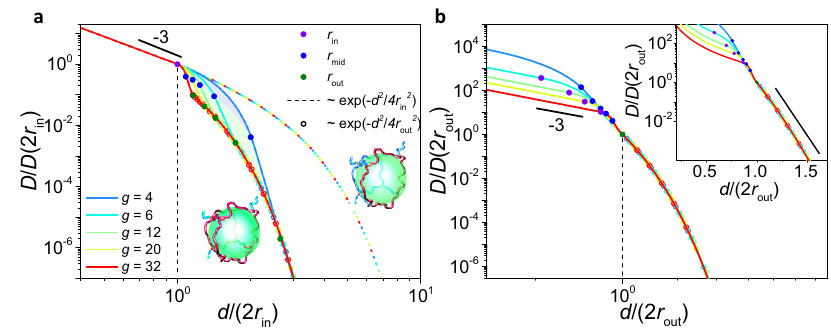
Fig. 4 Dynamical regimes mediated by network topologies. a D / D (2 r in ) against d /2 r in for various network cell topologies in the log-log scale. Inset: schematic diagrams of the deformation based on a network cell (left) and the deformation based on a network loop (right). b D / D (2 r out ) against d /2 r out for various network cell topologies in the log-log and the log-linear (inset) scales. The scaling parameters r in (purple), r mid (green) and r out (blue) are presented on each plot. Power law and exponential dependences on the ratio between d and 2 r in (dashed line) or 2 r out (circular scatter) are depicted.